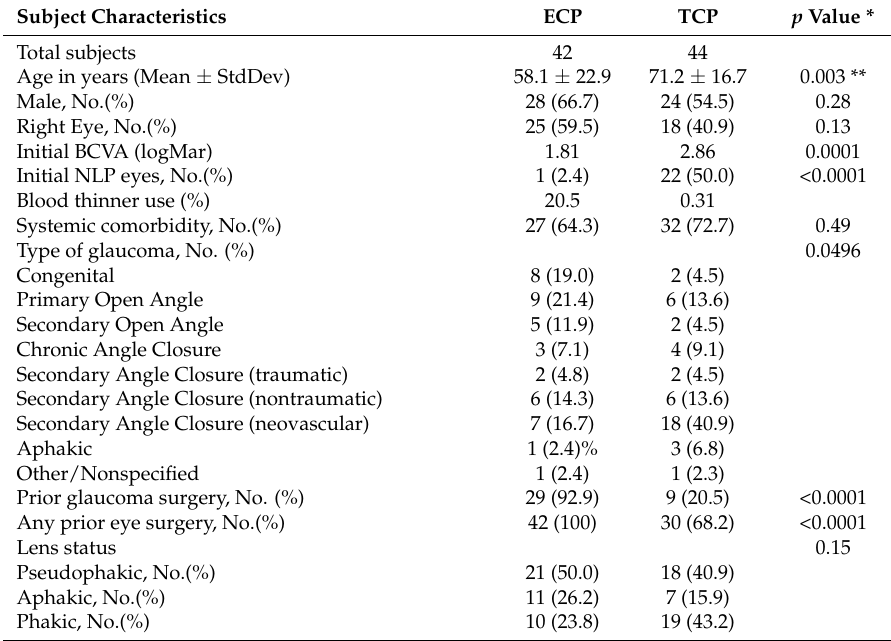
Table 1. Baseline Characteristics of